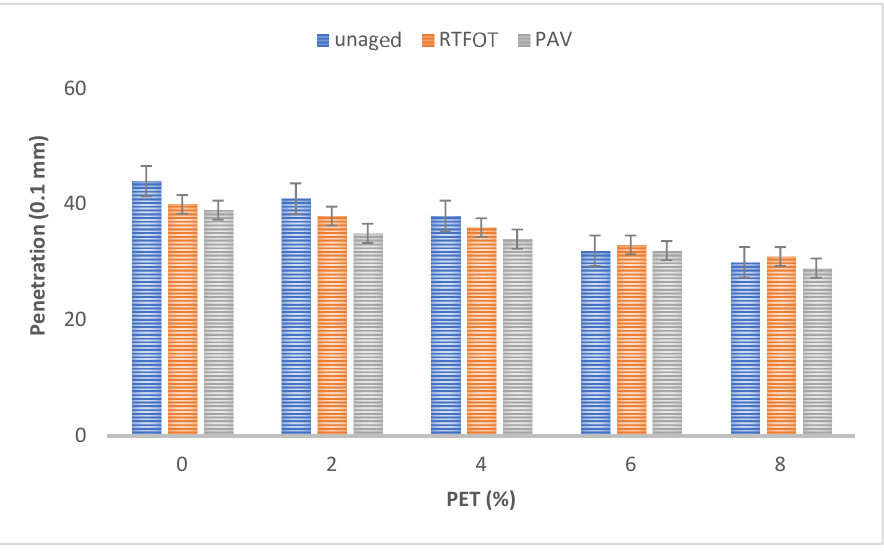
Figure 6. Penetration results for PET-modified bitumen after the RTFOT and PAV tests.